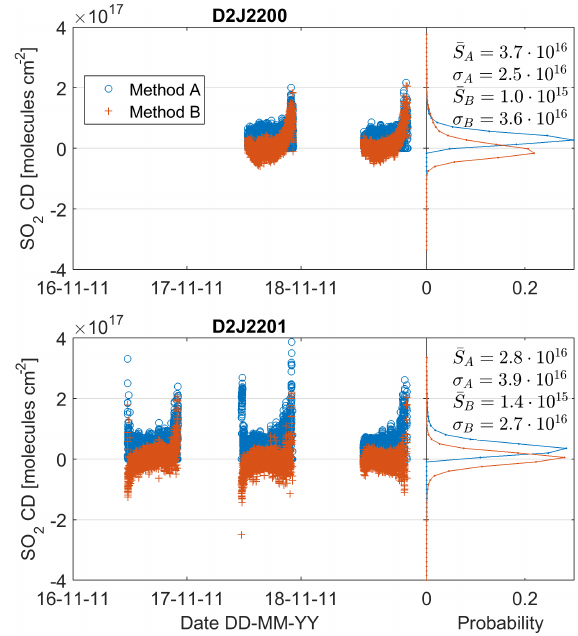
Figure 5. SO 2 column densities for days with presumably no SO 2 apparent in the light path for the two instruments at Nevado del Ruiz. The histogram on the right side shows the distribution of the values of both methods for all gas-free days in the data set. An in- crease in SO 2 CDs in the early morning and towards the evening can be observed. However, the histogram shows that this only influ- ences a small fraction of the data (typically for SZAs above 70 ◦